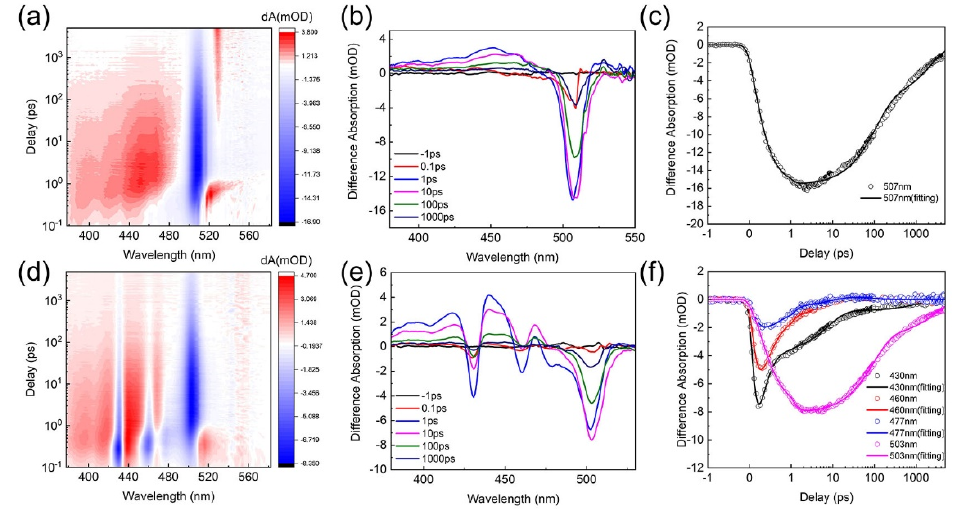
Figure 9. ( a ) Decay-wavelength-absorption characteristics. ( b ) Decay kinetics at different probe times. ( c ) Decay kinetics at different wavelengths of PEABr perovskite. ( d ) Decay-wavelength-absorption characteristics. ( e ) Decay kinetics at different probe times. ( f ) Decay kinetics at different wavelengths of m -PEABr perovskite.